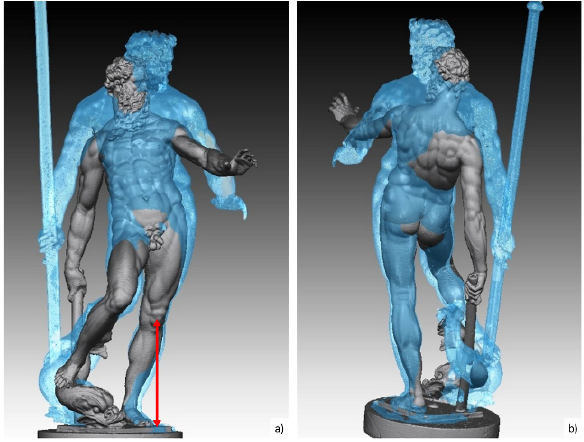
Figure 9. Two views of the comparison between the statues, after scaling the archetype using the length of the leg, evidenced in red (the light-blue model is the big Neptune, the grey model is the archetype).